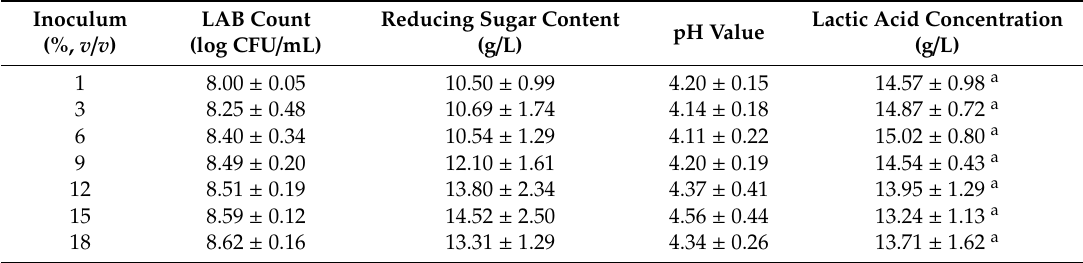
Table 4. The e ff ects of inoculum on lactic acid fermentation.